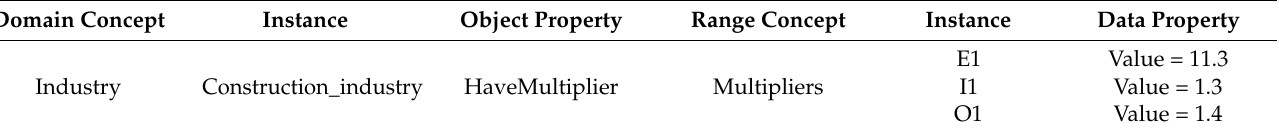
Table 2. Concept, object property and sub-concept population for Economic_environment . Domain